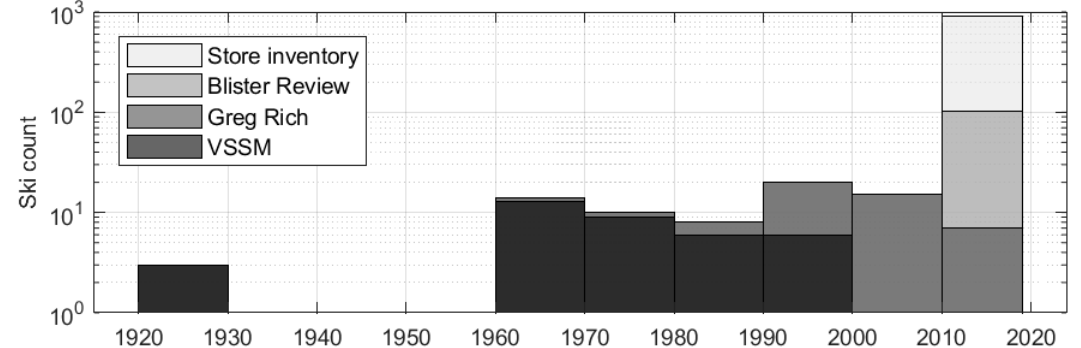
Figure 1. Model year distribution of measured skis, classified by